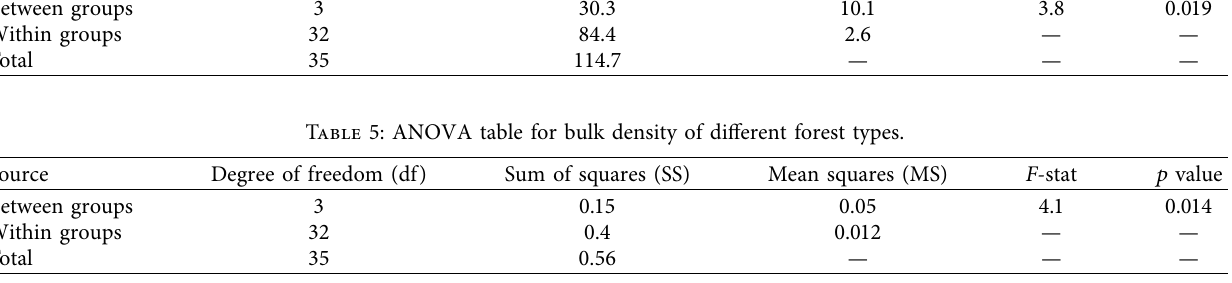
Table 4: ANOVA table for SOC stock of different forest types.